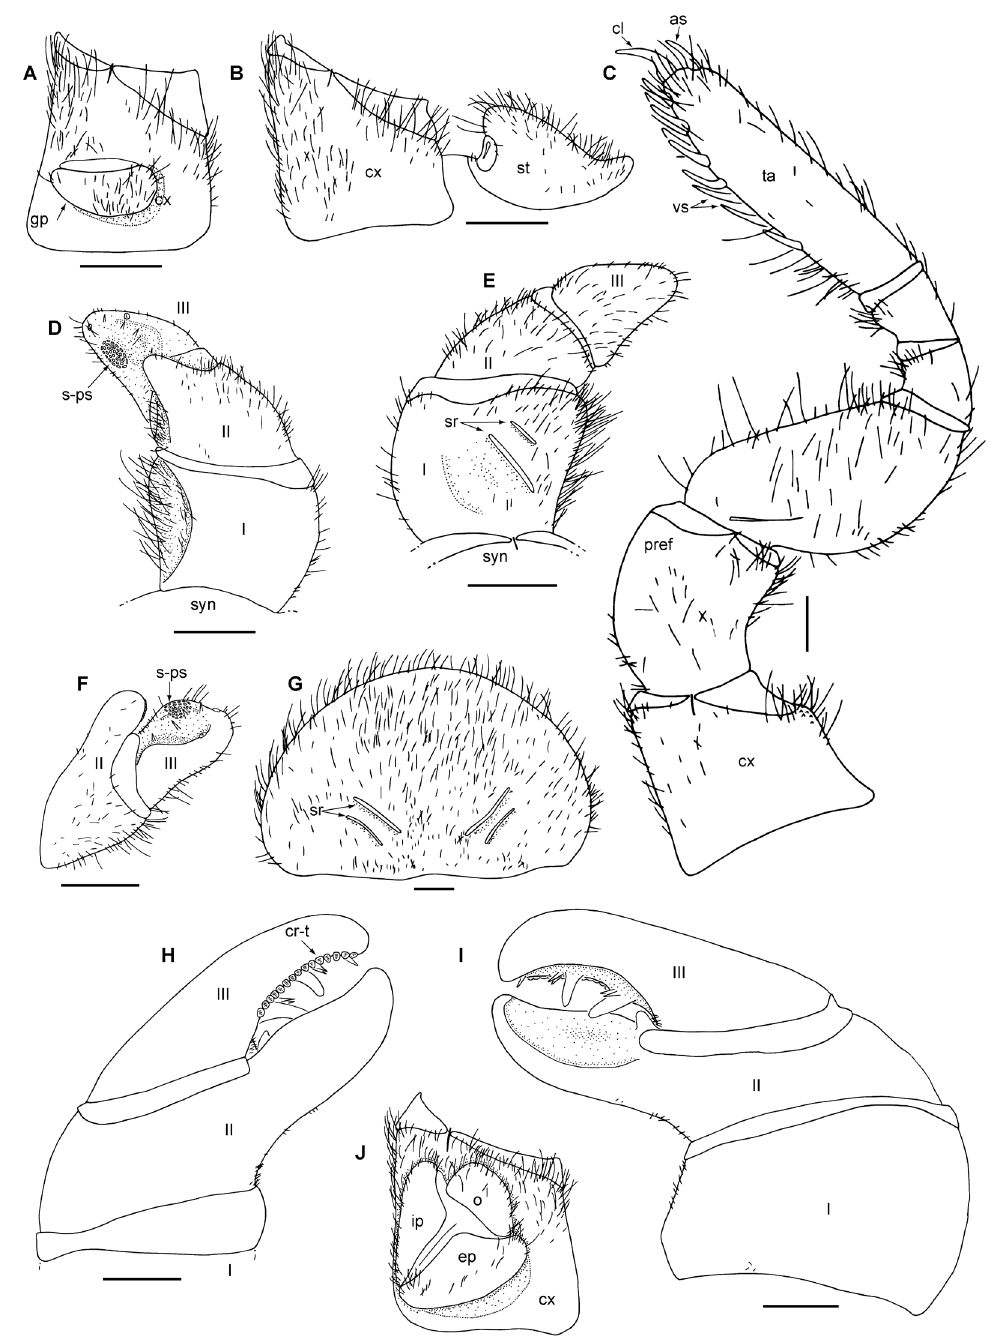
Fig. 6. Zoosphaerium silens sp. nov., holotype (FMNH-INS 3119887). A . Left coxa 2 with gonopore, posterior view. B . Left coxa 1 with stigmatic plate, posterior view. C . Left leg 9, posterior view. D . Left anterior gonopod, posterior view. E . Left anterior gonopod, anterior view. F . Left anterior gonopod, lateral view. G . Female subanal plate with washboard. H . Right posterior telopod, posterior view. I . Right posterior telopod, anterior view. J . Left female coxa 2 with vulva, posterior view. Abbreviations: as = apical spine; cl = claw; cr-t = crenulated teeth; cx = coxa; ep = external plate; gp = gonopore; ip = inner plate; o = operculum; pref = prefemur; s-ps = sclerotized spots; sr = stridulation rib; st = stigmatic plate; syn = syncoxite; ta = tarsus; vs = ventral spines. Roman numerals indicate telopoditomeres. Scale bars = 1